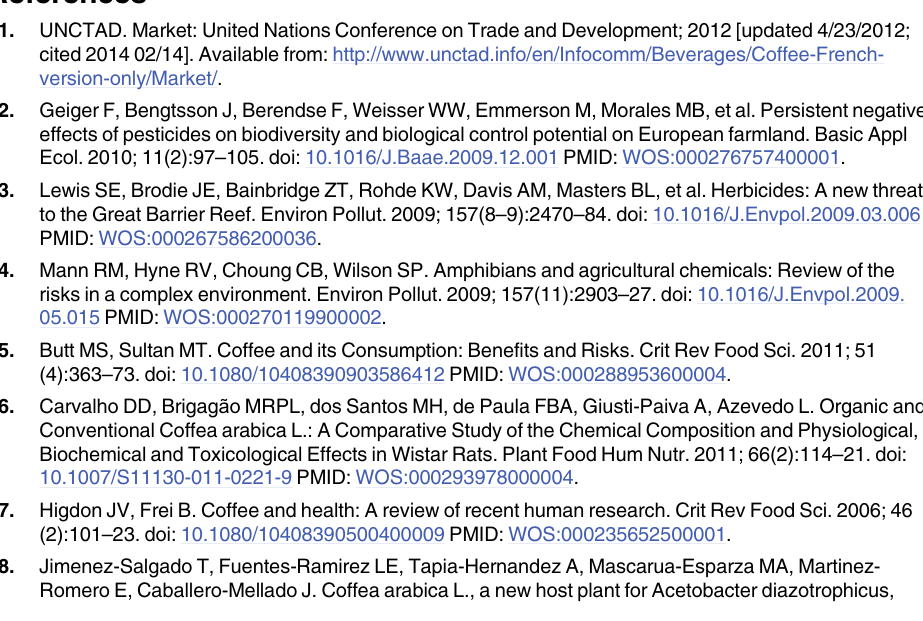
S2 Fig. Quantification of common families of nitrogen fixation bacteria. Relative abun- dance of nitrogen-fixing archaeal and bacterial family-level groups detected in the rhizosphere of each of the three farms (INT, ORG, and TRN) or all sites together (% of the Total). The fam- ily-level relative abundance was calculated as the percentage of sequences of each family found in the total number of sequences retrieved from each rhizosphere. The % of the Total was the number of family-level sequences divided by the total number of sequences from all sites com- bined. Even though a low number of sequences were retrieved from the genus level of the nitro- gen-fixing bacteria, the relative abundance of the respective families were some of the highest among all families in the